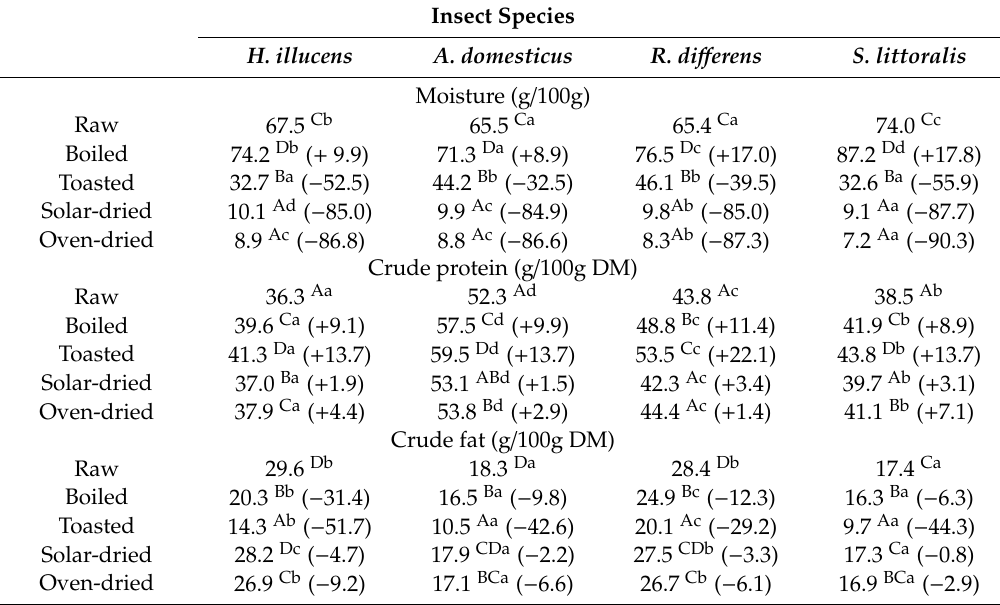
Table 1. Moisture, crude protein, and crude fat contents of raw and processed